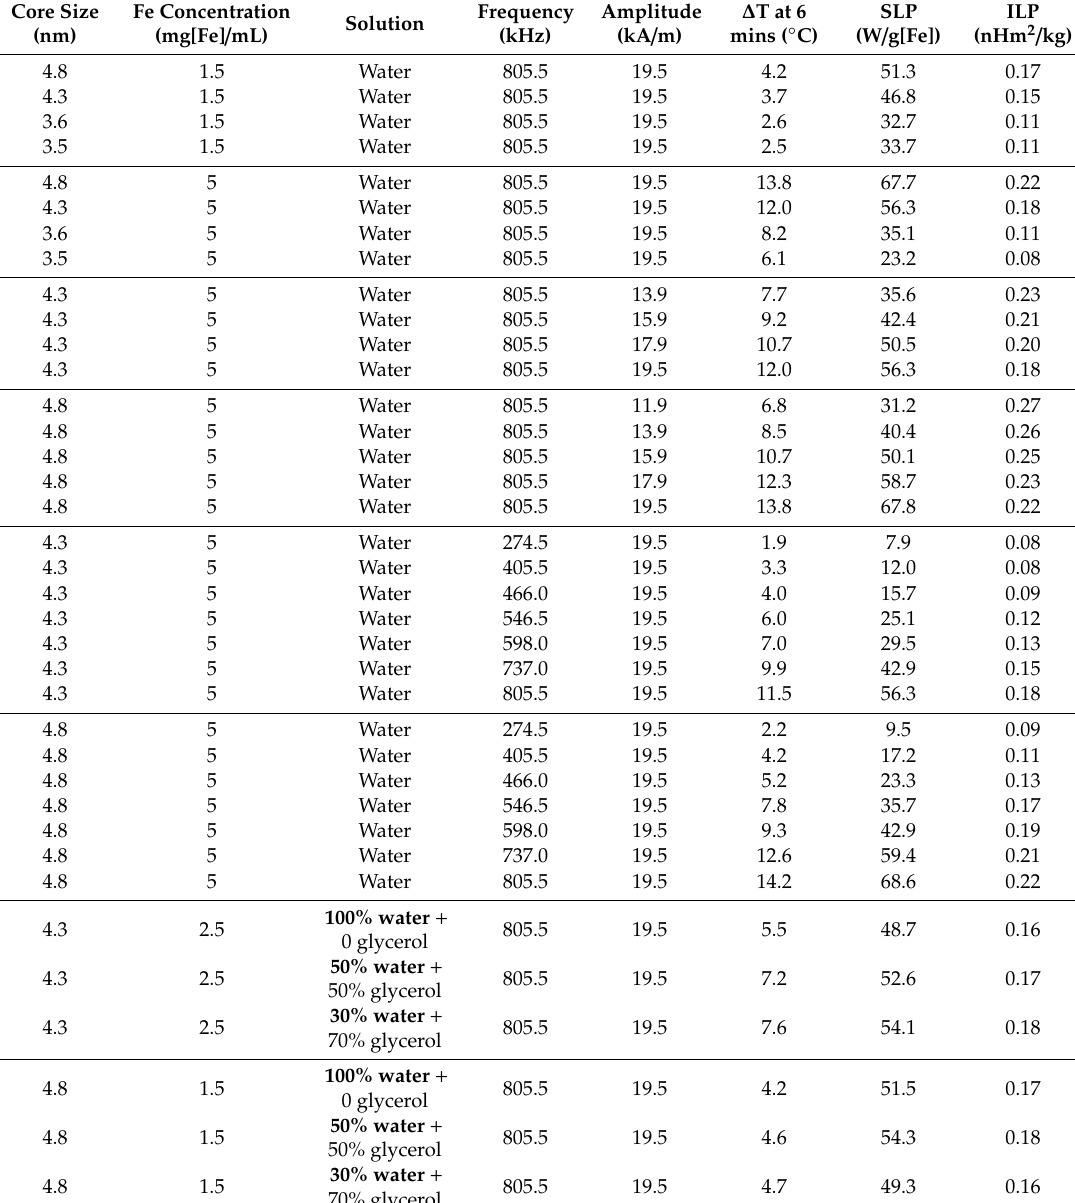
Table 2. Summary of temperature rise, SLP and ILP under di ff erent Fe concentration, medium and AMF parameter measurement